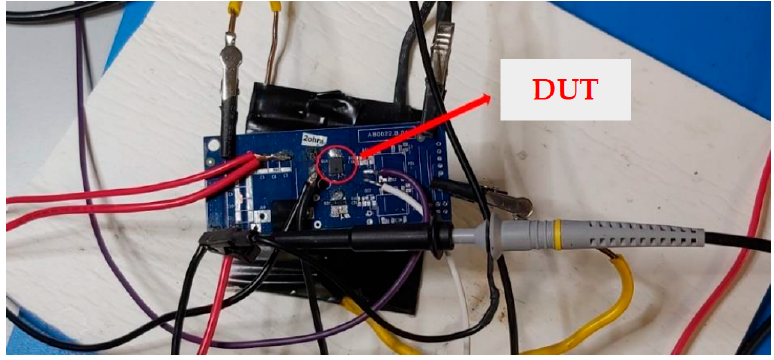
Figure 7. V ds measurement setup.